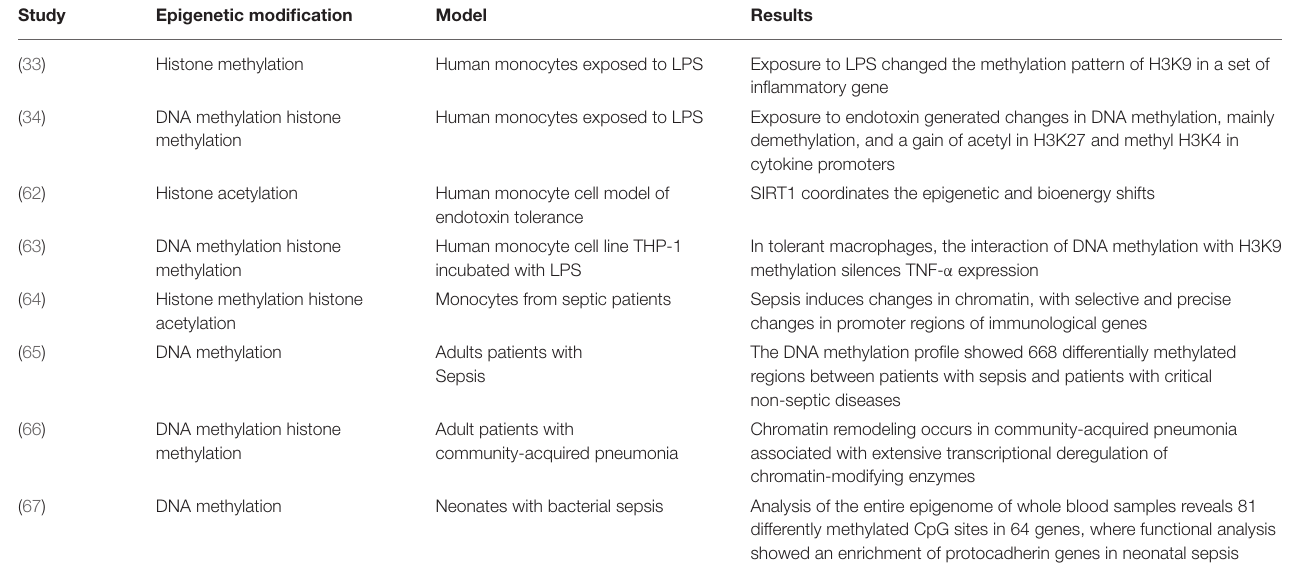
TABLE 3 | Epigenetic modifications in human cells in vitro and in different clinical